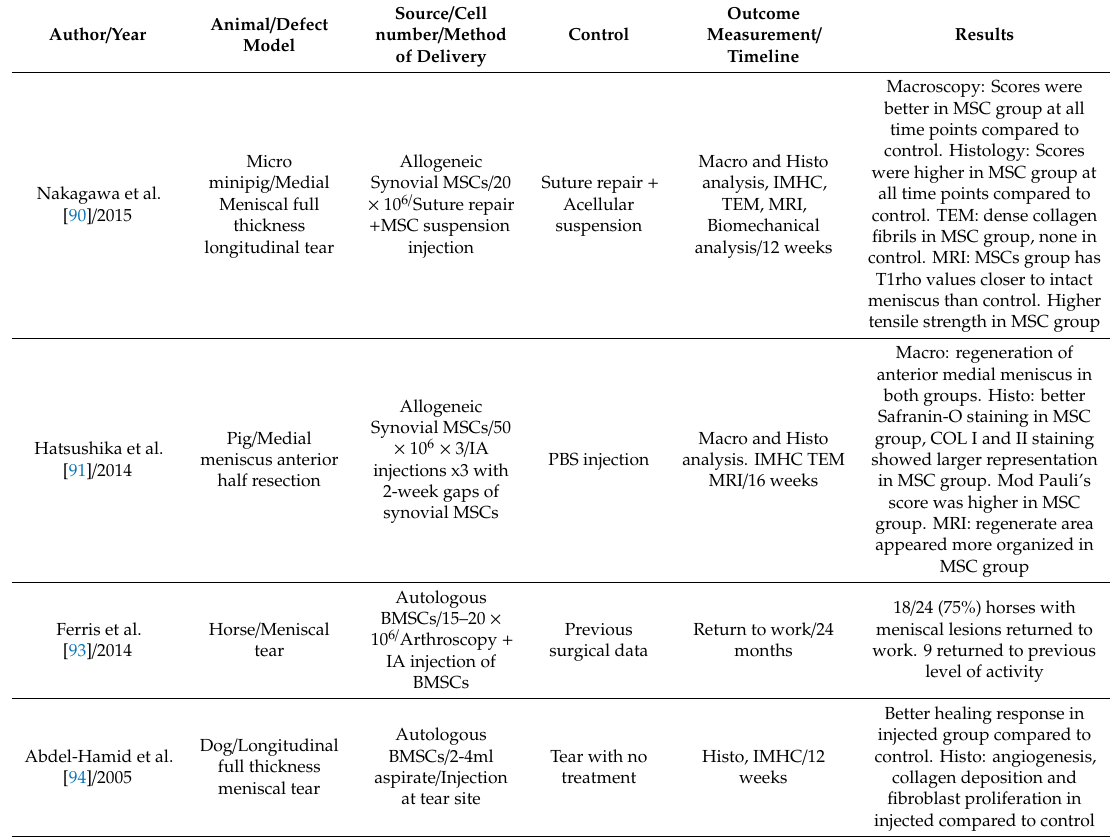
Table 2. Summary of pre-clinical studies using stem cell